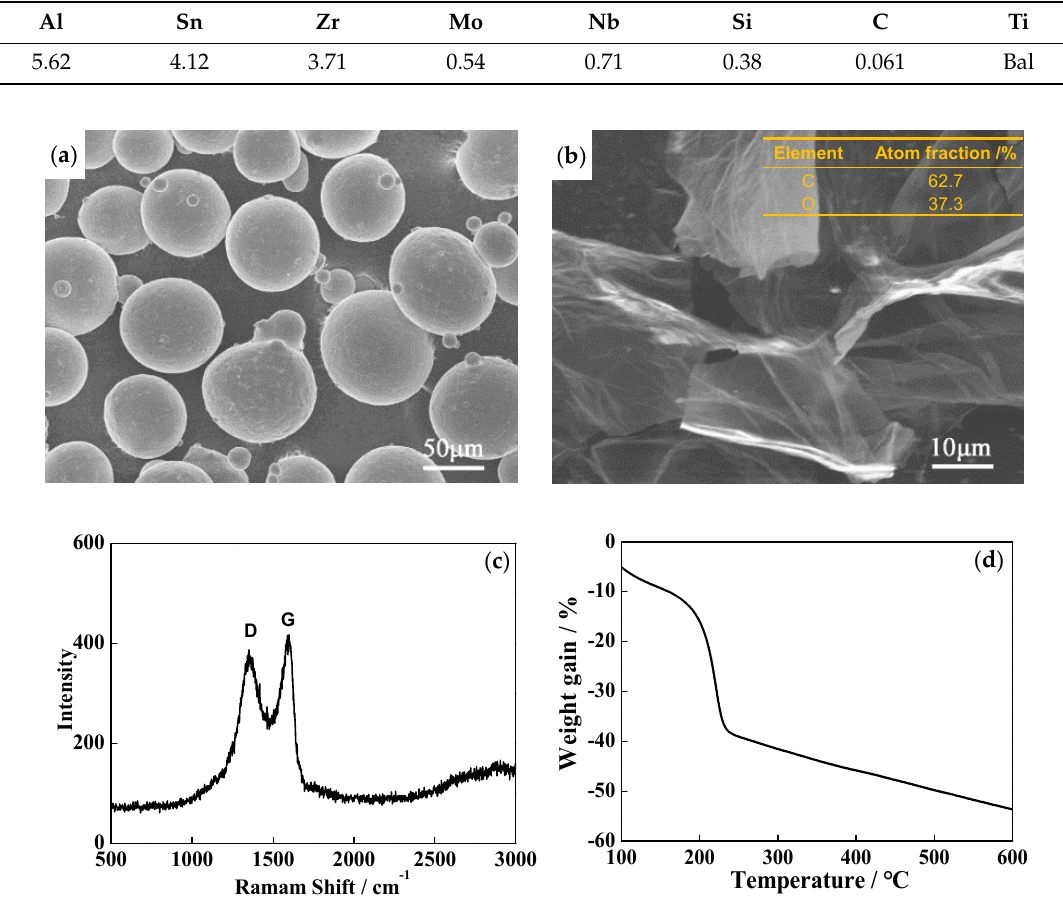
Figure 1. ( a ) SEM image of high-temperature titanium alloy powder; ( b ) SEM image of graphene oxide (GO), the insert table is EDS result of GO; ( c ) Raman spectrum of GO; ( d ) TGA plot of GO. Table 1. Chemical compositions of high-temperature titanium alloy (mass fraction/%).